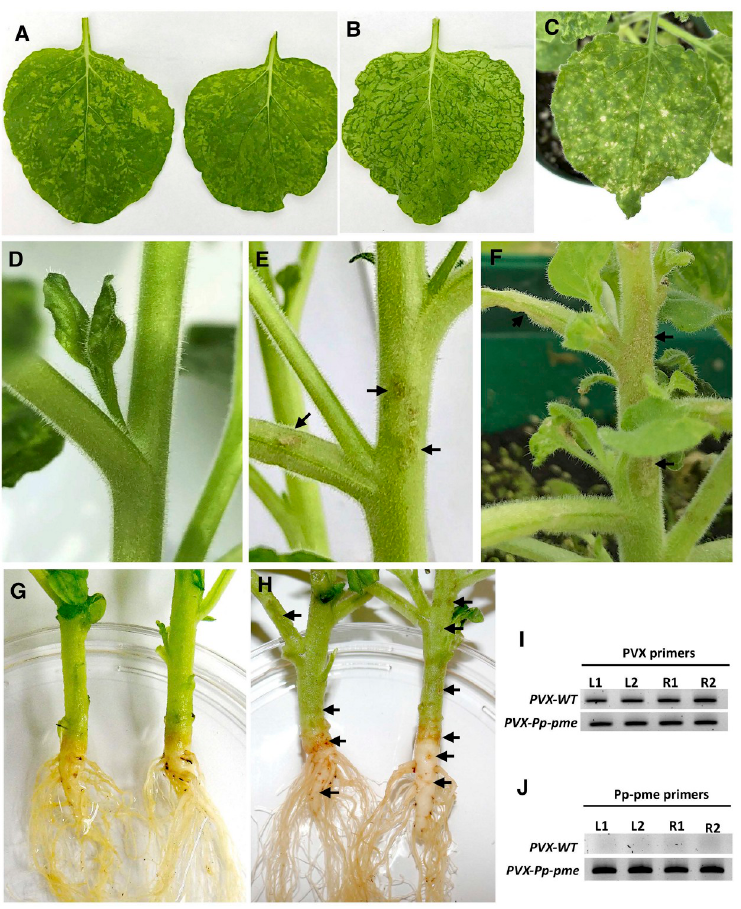
Fig 7. Phenotypic changes in Nicotiana benthamiana plants infected with the recombinant PVX-Pp-pme virus. All photos were taken 14 days after inoculation. (A) characteristic mosaic-like symptom developed in N . benthamiana plants infected with transcripts generated from the empty PVX vector. ( B-C ) Distinct leaf chlorosis symptoms (B) and lesion-like spots (C) developed in N . benthamiana plants infected with PVX-Pp-pme transcripts, respectively. (D) Stem and branches of the N . benthamiana plant infected with transcripts generated from the empty PVX vector displayed no symptoms. (E-F) Lesion-like symptoms observed on stems and branches of N . benthamiana plants infected with PVX-Pp-pme transcripts. (G) Stem and roots of N . benthamiana plant infected with empty PVX vector displayed no symptoms. (H) Browning in the area of the stem-root joint and lesion-like spots observed on the roots of N . benthamiana plants infected with PVX-Pp-pme transcripts. (I-J) Detection of PVX-WT and PVX-Pp-pme transcripts in inoculated N . benthamiana plants by semi-quantitative RT-PCR. L1, L2: leaves from two independently-inoculated plants; R1, R2: roots from two independently-inoculated